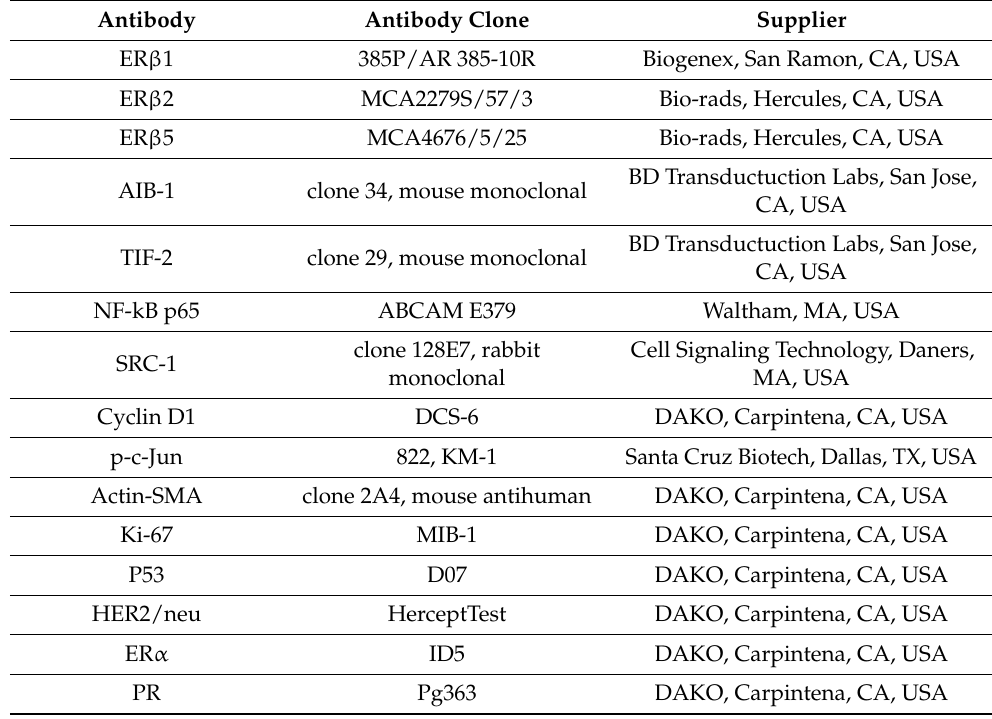
Table 1. Antibodies for immunohistochemistry